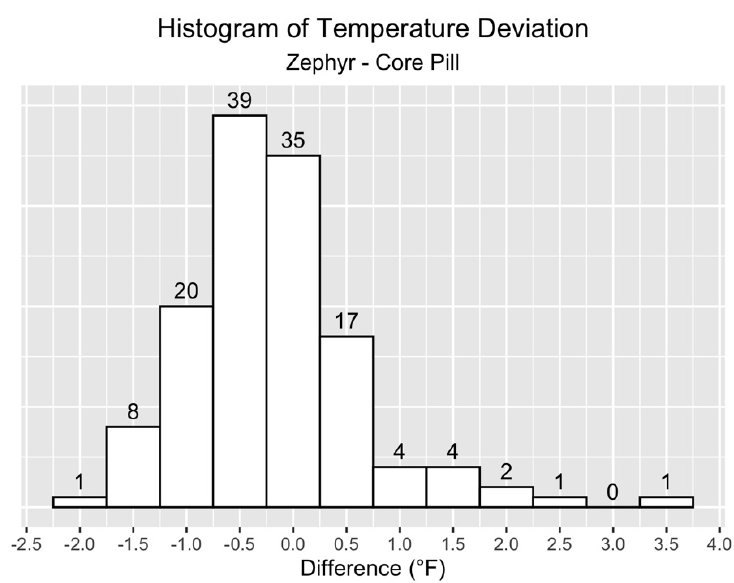
Figure 3. Histogram of ECT versus Gold Standard: number of observations (Y-axis) within given ranges of error (X-axis).